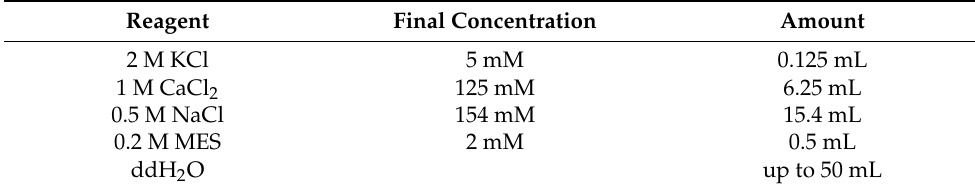
Table 3. Composition of W5 buffer (50